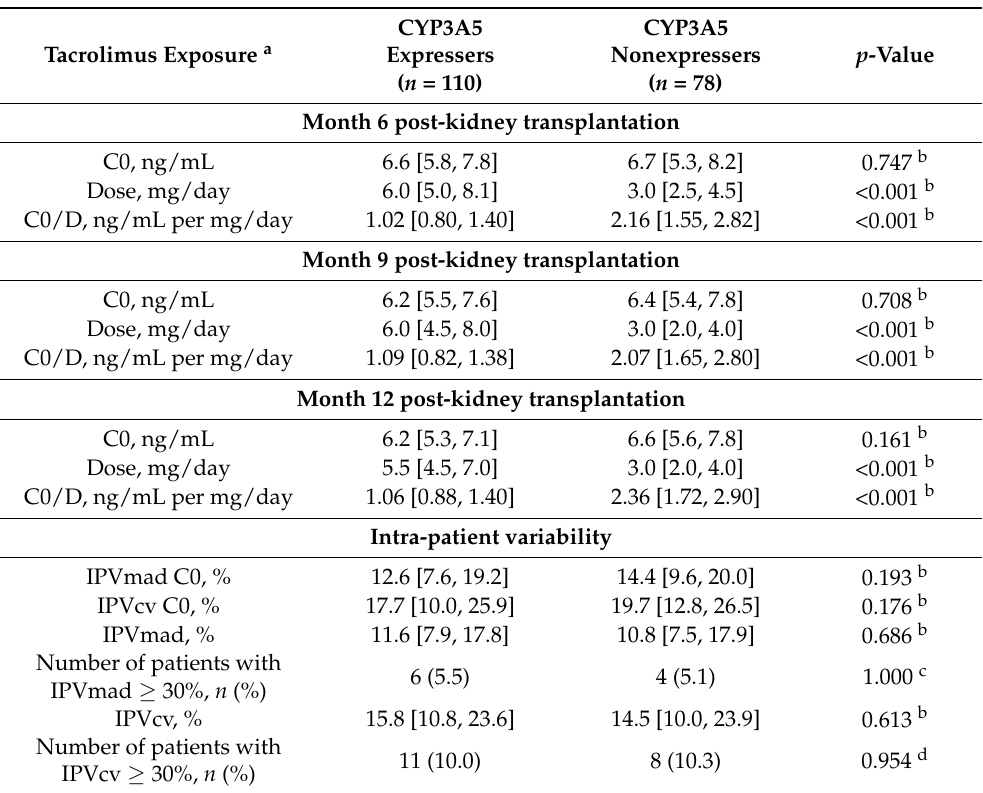
Table 2. Tacrolimus exposure during months 6 to 12 post-kidney